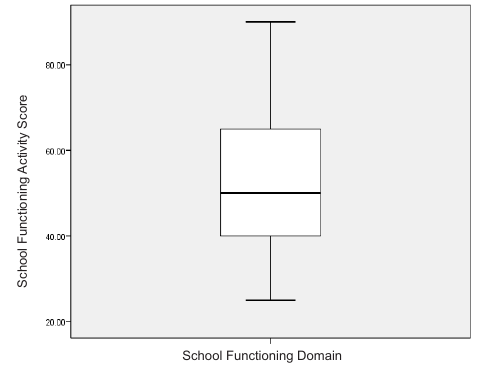
Figure 1. Box and Whisker Plot Showing School Activity Score of Thalassemic Children (n = 292).